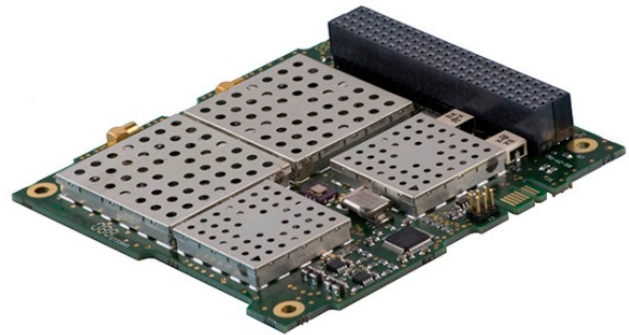
Figure 30. UHF Downlink/VHF Uplink Transceiver [47].